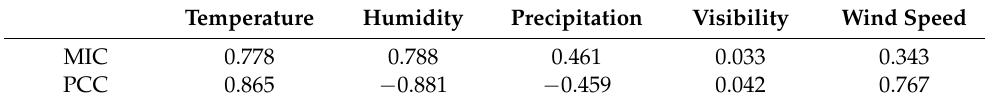
Table 1. Correlation coefficient between electric vehicle charging load and meteorological factors.